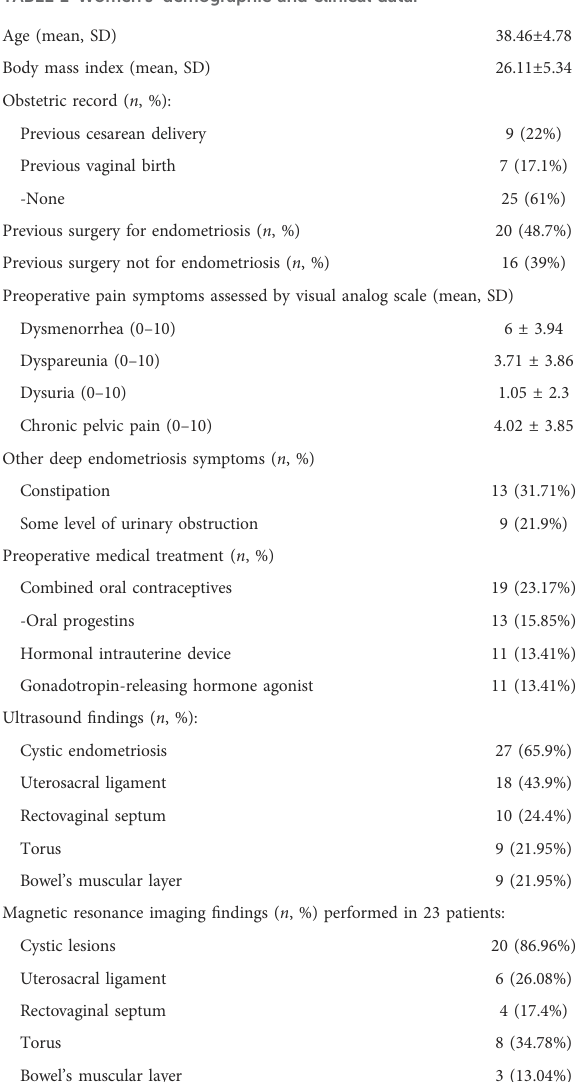
TABLE 1 Women ’ s ’ demographic and clinical